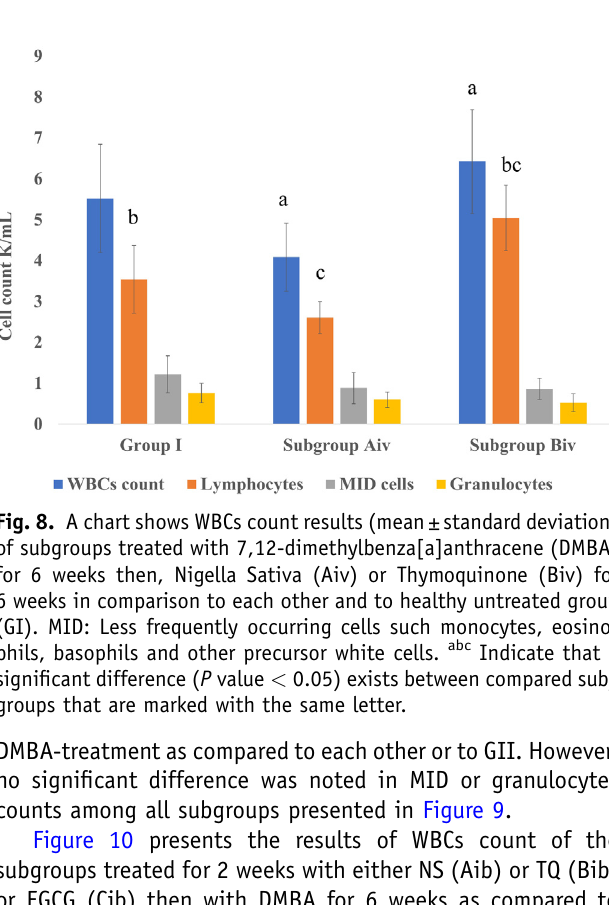
Fig. 7. A chart shows WBCs count results (mean ±standard deviation) of different experimental subgroups compared to group I and II. Group I included healthy untreated animals, Group II included animals treated with 7,12-dimethylbenza[a]anthracene (DMBA) for 6 weeks, Subgroup Aia included animals treated with Nigella Sativa for 2 weeks, subgroup Bia included animals treated with Thymoquinone for 2 weeks and subgroup C included animals treated with ( – )-Epigallocatechin-3- gallate for 2 weeks. MID: Less frequently occurring cells such as monocytes, eosinophils, basophils and other precursor white cells. a Indicates that a signi fi cant difference ( P value < 0.05) exists with group I. b Indicates that a signi fi cant difference ( P value < 0.05) exists with group II.